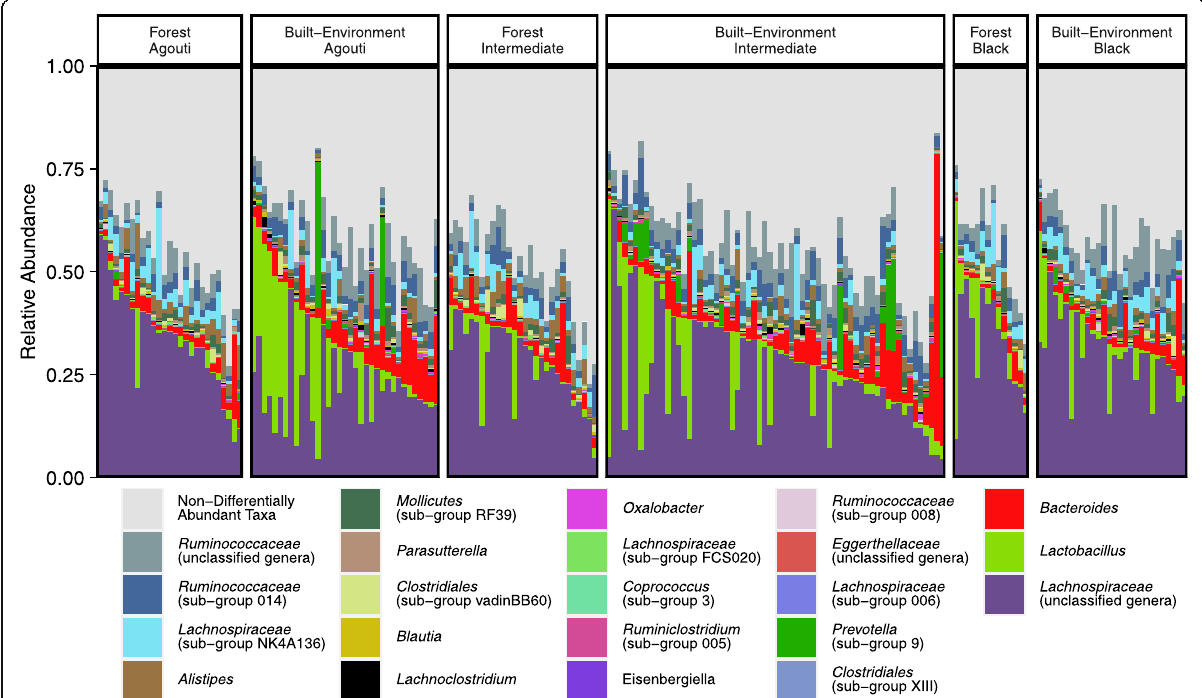
Fig. 6 A stacked barplot of bacterial genera indicated by ANCOM-BC analyses to significantly differ in relative abundance between forest and built-environments in the full dataset or among at least one coat colour phenotype. Facetted by coat colour phenotype and environment